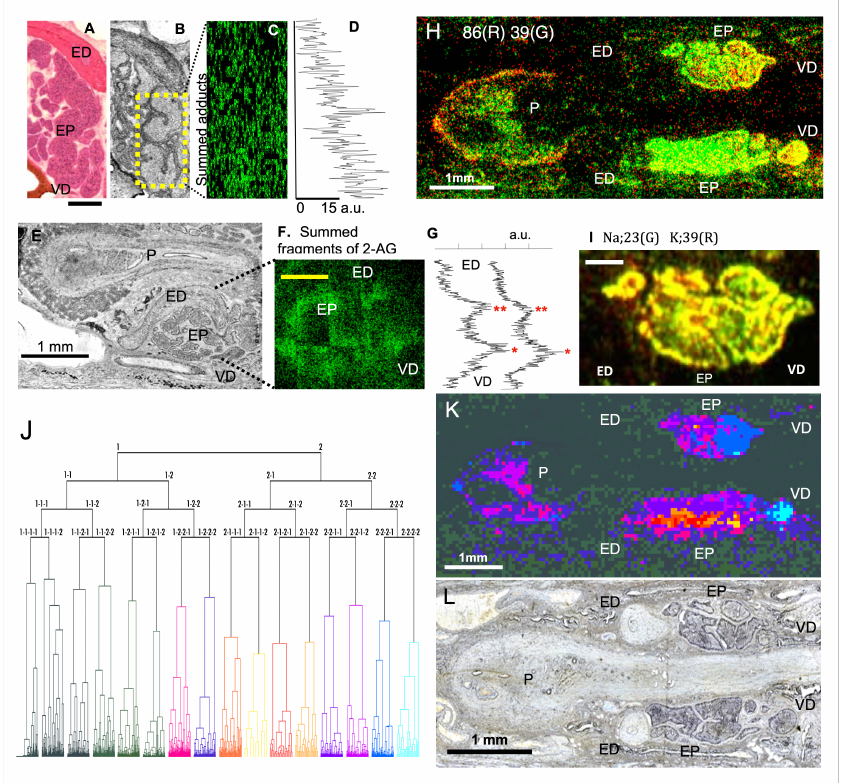
Figure 5. ( A ) An epididymis section stained with hematoxylin-eosin (8 µm thick). ( B ) An optical image taken from a neighboring section in the same epididymis shown in ( A ). ( C ) The image of 2-AGaddctSum acquired in the same section shown in ( B ). The ion image was taken from the area enclosed by the yellow box. ( D ) A plot for the average signal intensity calculated in individual pixel rows in 2-AGaddctSum shown in ( C ). The plot exhibited that the signal was 15 times stronger in arbitrary units in the bottom pixel row (near VD close to the head) than in the top pixel row (near ED close to the tail), suggesting a gradual decrease in 2-AG signals from the head to the tail. ( E ) An optical image of an epididymis section. ( F ) The image of 2-AGfragSum acquired in the same section in ( E ). ( G ) A plot for the average signal intensity in individual rows in 2-AGfragSum. The peak intensity was higher in the head (one asterisk) than the tail (two asterisks) of the epididymis. ( H ) Image for m / z 86. ( I ) Distribution of Na ( m / z 23) and K ( m / z 39) were color-coded in the epididymis. Na (green) was higher in the head of the epididymis, whereas K (red) was higher in the tail of the epididymis. ( J ) Individual segments (defined in the text) were organized into hierarchical clusters (dendrogram) based on the similarity in the peak profile of the mass spectrum. Segments were categorized into 16 groups at the fourth branching point in the dendrogram. Each cluster is marked by a different color. ( K ) The STCM image was colored according to the color code in the dendrogram in ( J ). ( L ) The optical microscope image that corresponds to the MS image shown in ( H , K ). EP: epididymis; ED: ejaculatory duct; P: penis; VD: vas deference. Calibrations: 300 µm ( A , F , I